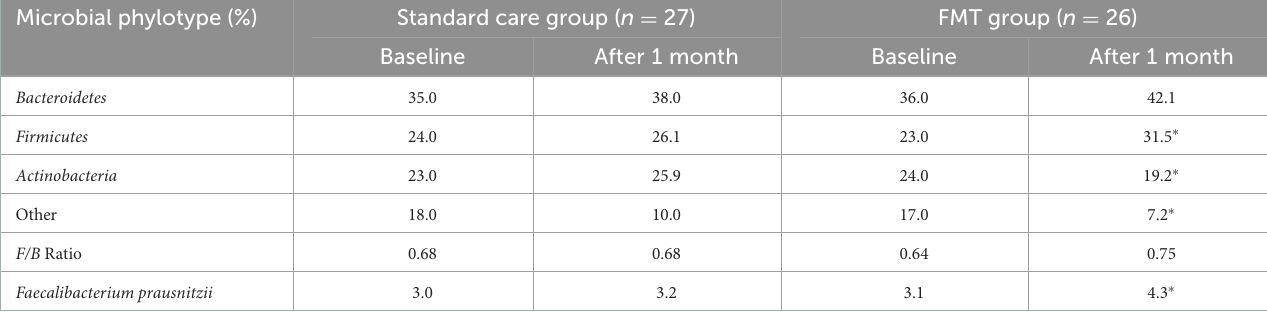
TABLE 3 Contents of the main phylotypes of microorganisms in patients with UC at baseline and 4 weeks after treatment (%). Microbial phylotype